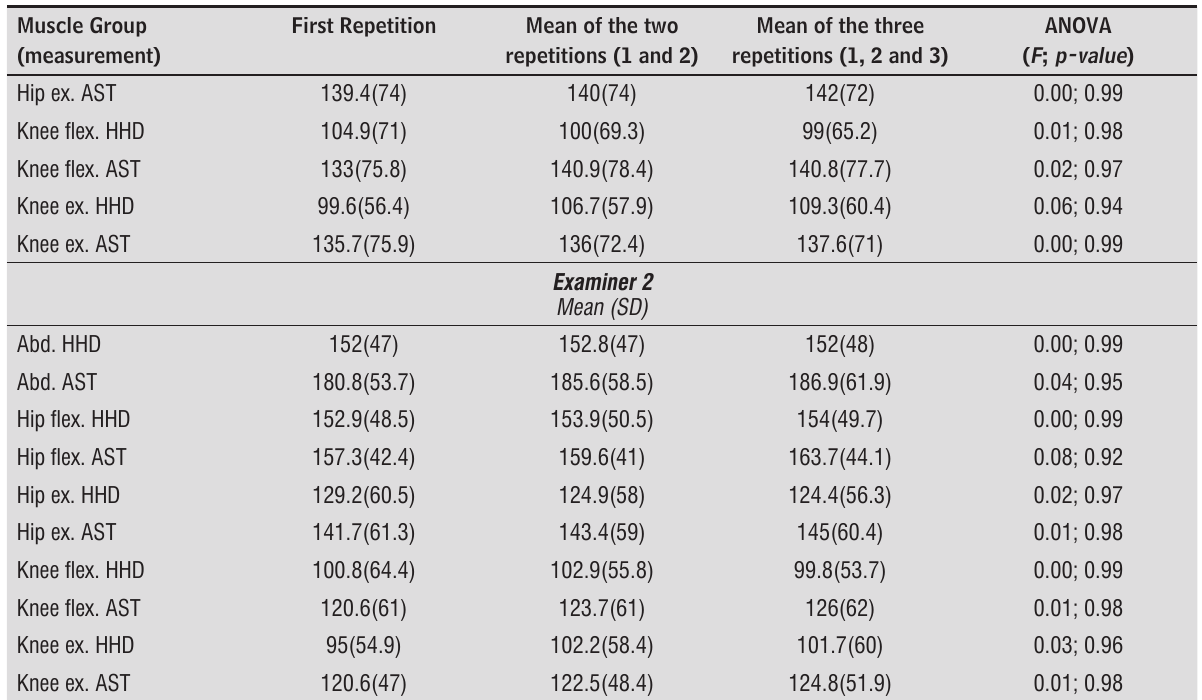
Table 2 - Descriptive data of muscle strength with different forms of measurement, AST (mmHg) and HHD (N), and results of the analysis of variance (ANOVA) among the three repetitions investigated, considering the first session and examin- ers 1 and 2, n = 22